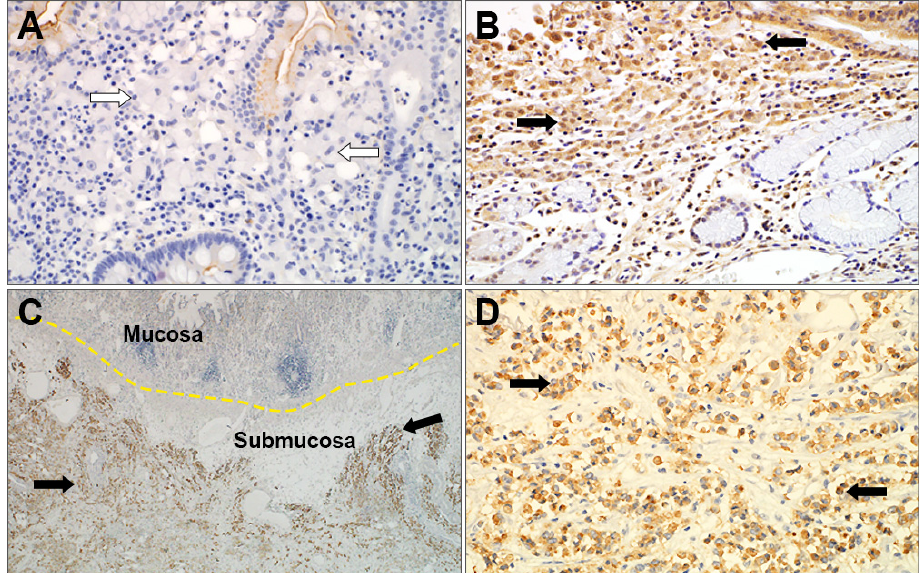
Figure 4. Representative images of PTPRM immunohistochemical staining. PTPRM showed ( A ) negative staining of the signet ring cell carcinoma (white arrow) and ( B ) positive staining of the poorly cohesive carcinoma (black arrow) in the mucosa. PTPRM highlighted the infiltrating pattern of ( C ) poorly cohesive carcinomas in the submucosa (×200) and ( D ) poorly cohesive carcinoma in the invasive front (×400).